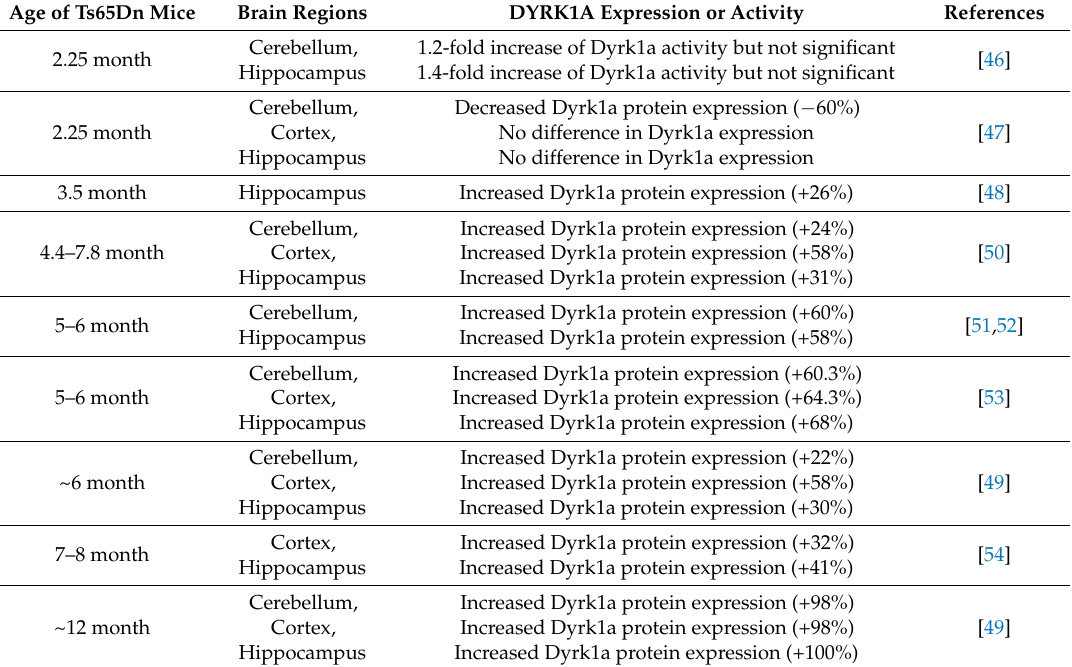
Table 2. Dyrk1A expression (or activity) in brain regions at different ages of Ts65Dn mice. Age of Ts65Dn Mice Brain Regions DYRK1A Expression or Activity